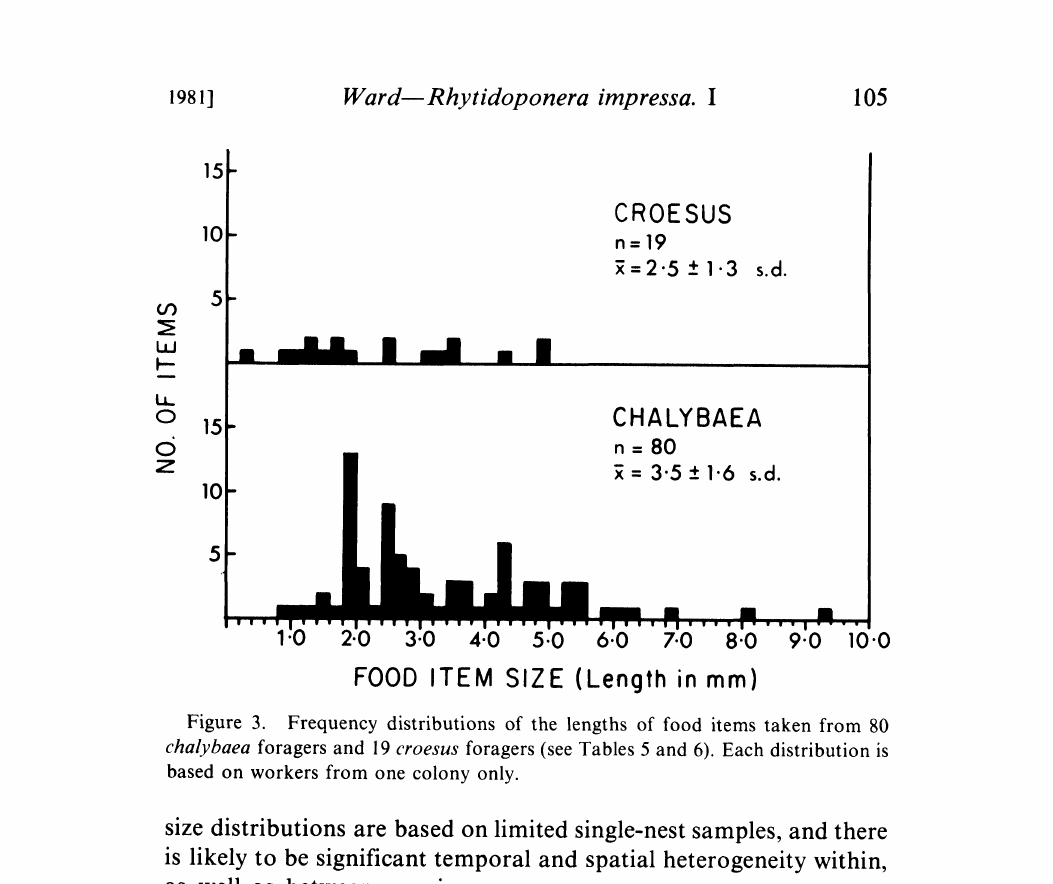
Figure 3. Frequency distributions of the lengths of food items taken from 80 chalybaea foragers and 19 croesus foragers (see Tables 5 and 6). Each distribution is based on workers from one colony